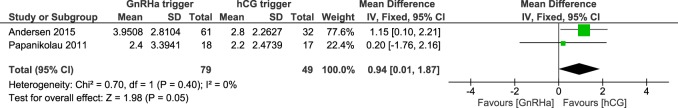
GnRH agonist (GnRHa) trigger versus hCG trigger, important outcome good quality embryos/intention to treat. Good quality embryos defined differently. In Ref. (16) as Grade 0, 1 day 2 or 3. In Ref. (15), a composite mean of embryos transferred and embryos frozen.